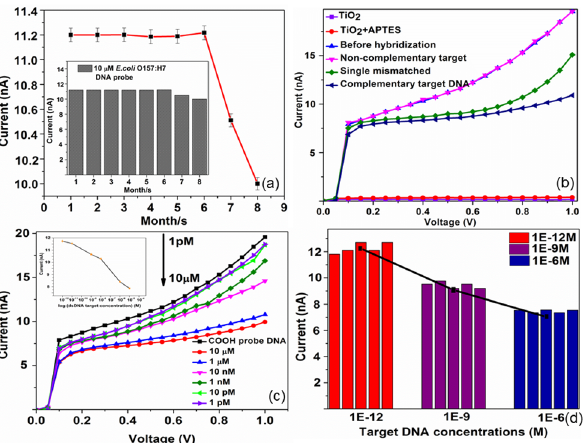
Fig 6. Responses on the sensing surface. (a) Current response of the 10 μ M probe of E . coli O157:H7 ssDNA concentration measured over 8 months. Inset shows the corresponding histogram of the peak current values on a sensor for 8 months.(b) Current responses of different target DNA hybridized on the 10 μ M probe DNA. These results proved the ability of the fabricated device to differentiate the positive and negative controls. (c)Current to voltage curves of the complemented target DNA concentrations. Inset shows the current values of different target DNA concentrations over the range 1E-12, 10E-12, 1E-9, 10E-9, 1E-6 and 10E-6 M. (d) Average current measurements of three different targeted DNA concentrations, 1 pM, 1 nM and 1 μ M. The corresponding histogram shows the current values after 5 hybridization